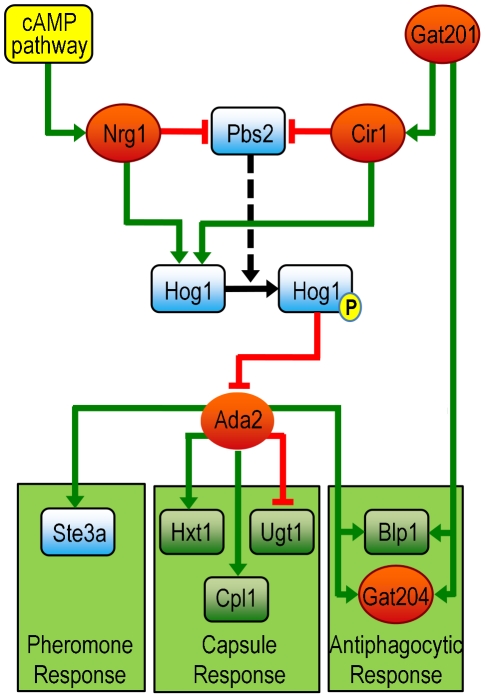
A model of Ada2 within the broader network of capsule, mating, and antiphagocytic responses (see text for details).Links from Cir1 and Nrg1 are supported by RNA-Seq data presented here. Links from Hog1 and Pbs2 are supported by published microarray data [47]; links from Gat201 are supported by published data from microarrays and ChIP-chip [24]; and links from Ada2 are supported by RNA-Seq and ChIP-chip data presented here. Red ovals, transcription factors; blue rounded rectangles, signaling proteins; green rounded rectangles, other proteins; green lines, stimulation of transcription; red lines, inhibition of transcription; solid black arrow, phosphorylation; P, phosphate; dashed arrow, catalysis by Pbs2.